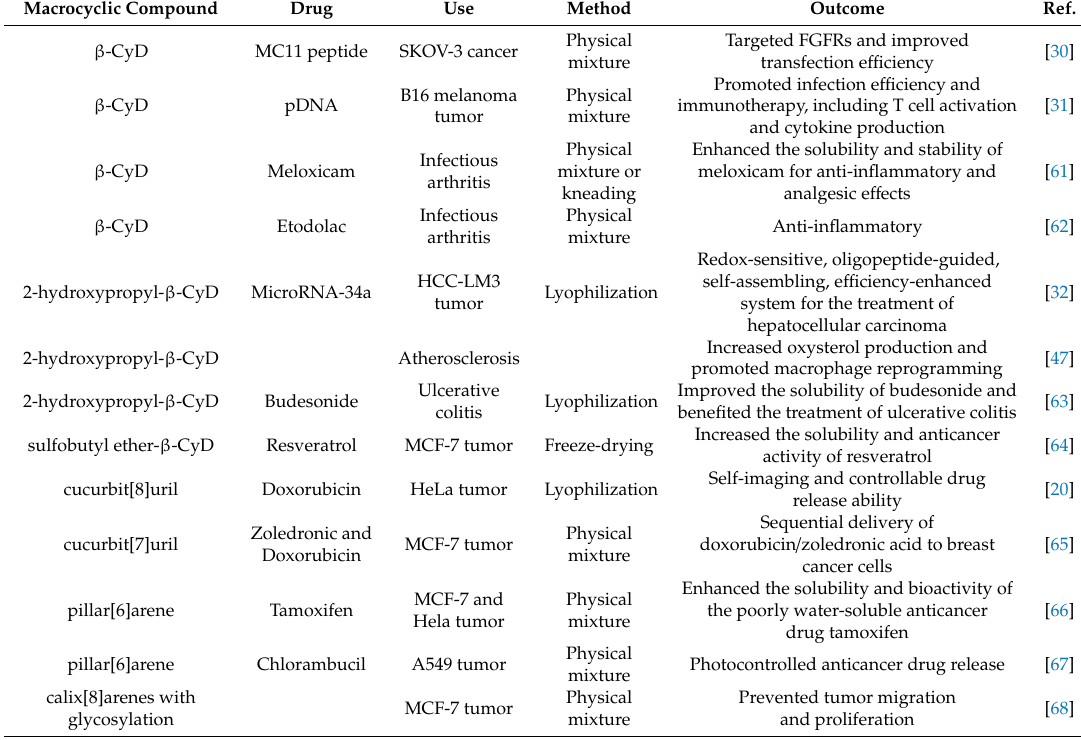
Table 1. Macrocyclic compound-based